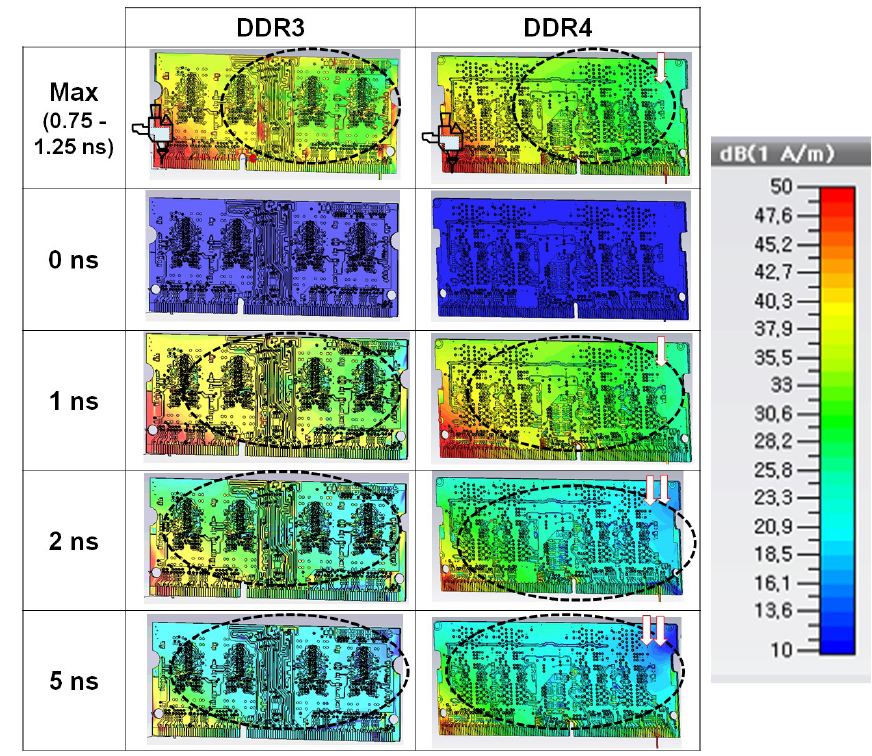
Figure 10. Comparison of current distribution for DDR3 and DDR4 for +2 kV voltage level.